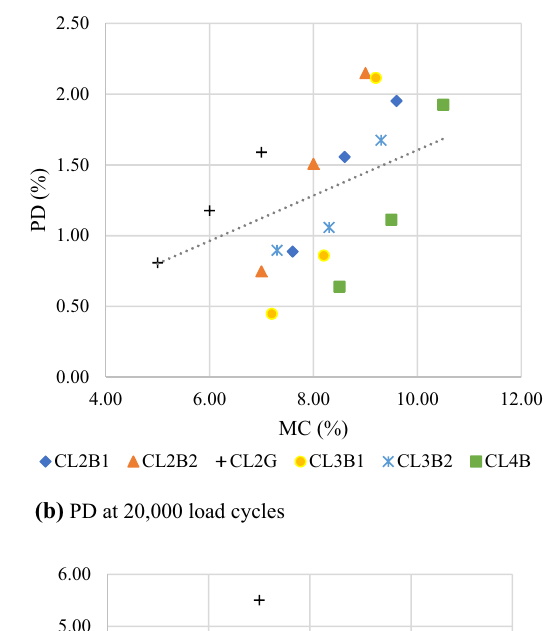
Fig. 5 Specimen preparation